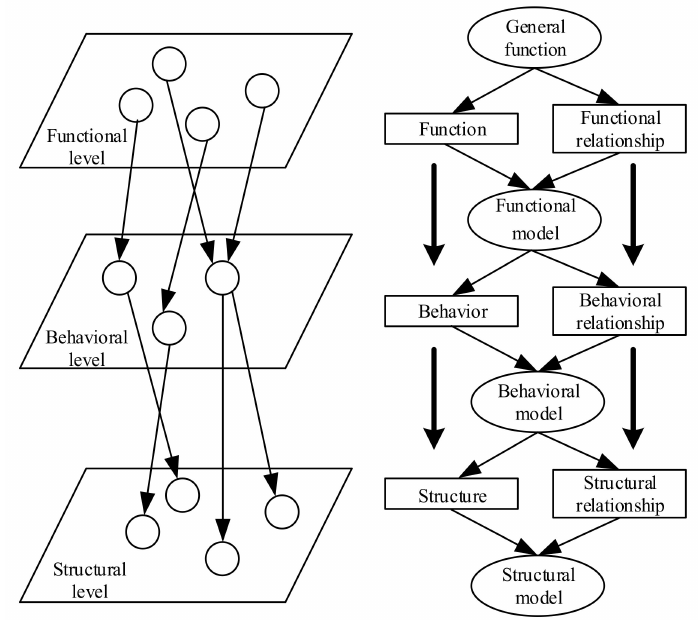
Figure 1. System design based on function–behavior–structure model